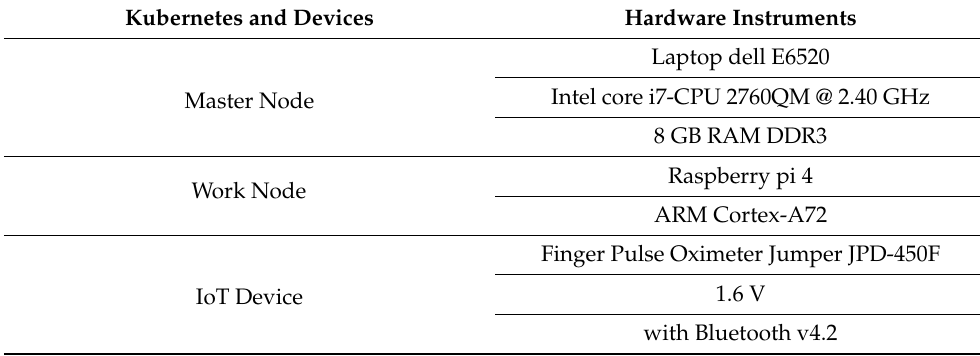
Table 2. Details and configuration of hardware.